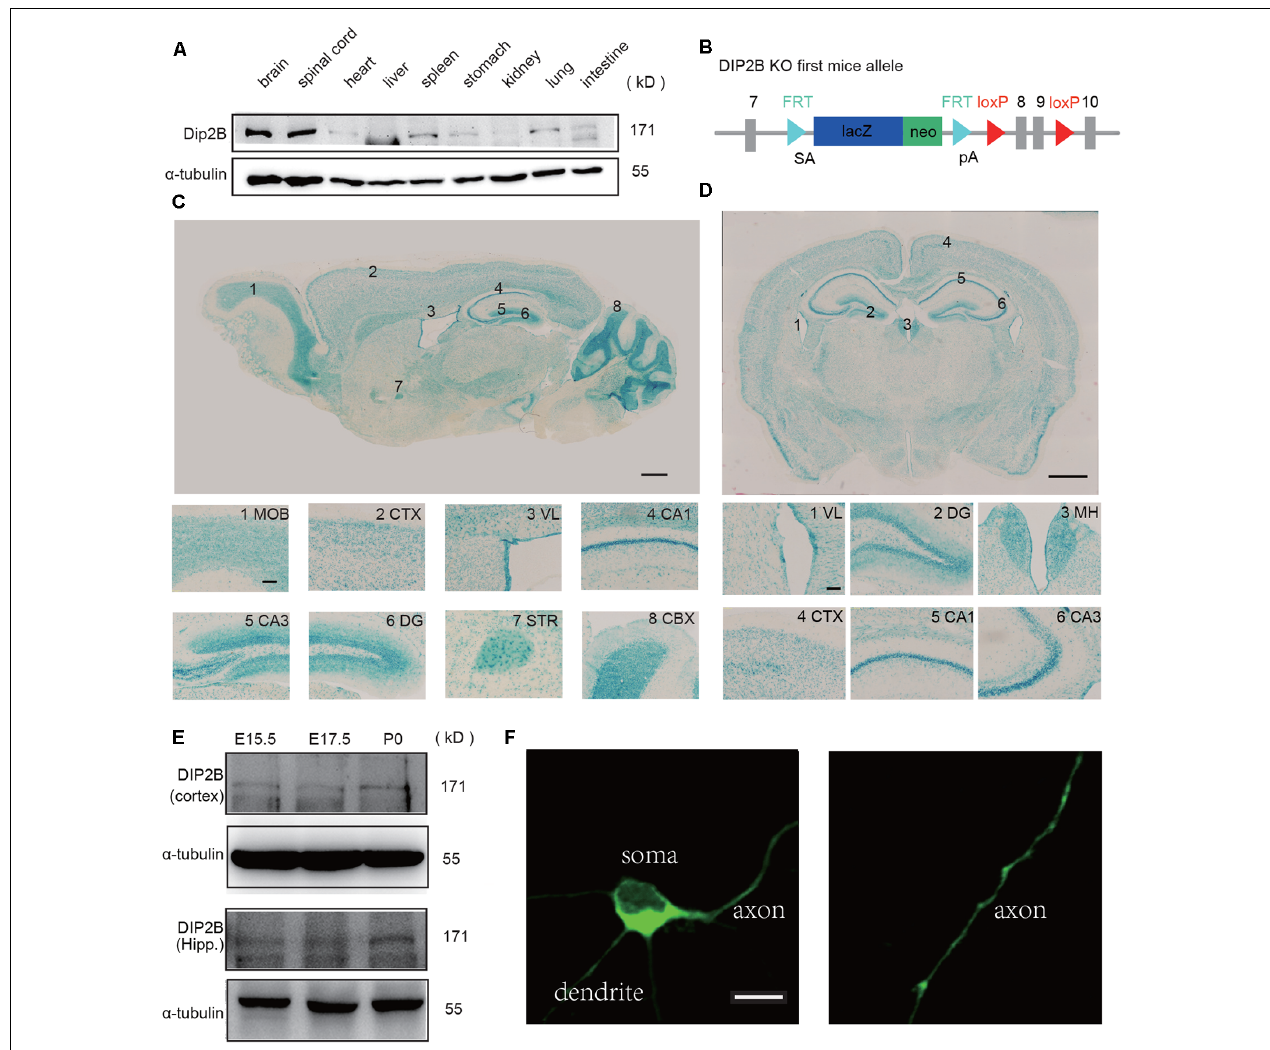
FIGURE 1 | DIP2B is highly expressed in excitatory hippocampal neurons. (A) Western blots of DIP2B expression in the different mouse organs. (B) Schematic depiction of DIP2B-LacZ mice. (C) Staining of sagittal slices from DIP2B-LacZ mice. Scale bar: 1 mm; subfigure: 50 µ m. (D) Staining of coronal slices from DIP2B-LacZ mice. Scale bar: 1 mm; subfigure: 50 µ m. (E) DIP2B expression during early developmental stages. (F) Overexpression of DIP2B-GFP in cultured hippocampal neurons. Scale bar: 10 µ